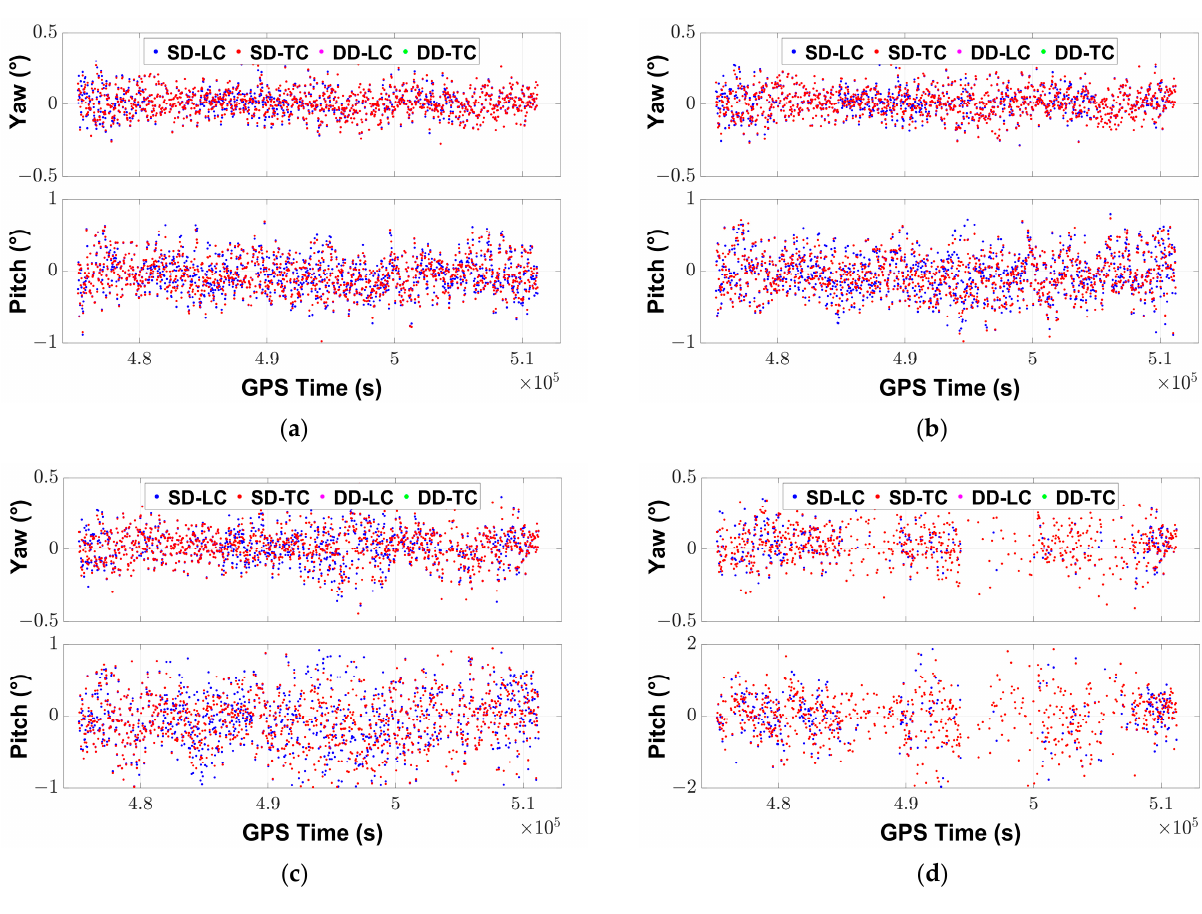
Figure 5. The yaw and pitch error series of the DD-LC, DD-TC, SD-LC, and SD-TC models under different elevation cutoff angles in the single-epoch solution: ( a ) 10°; ( b ) 20°; ( c ) 30°; and ( d ) 40°. Table 6. The yaw and pitch RMS errors of the DD-LC, DD-TC, SD-LC, and SD-TC models under different elevation cutoff angles in the single-epoch solution.